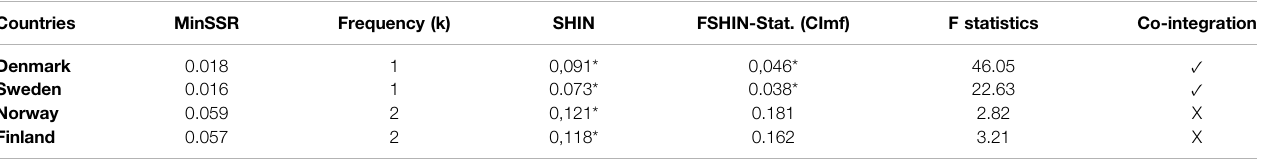
TABLE 6 | Fourier – Shin co-integration test results.